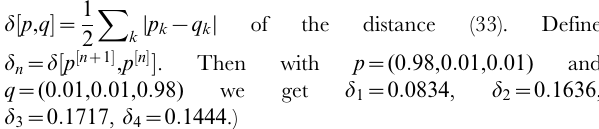
p ffiffiffiffiffiffiffiffiffiffiffiffiffiffiffiffiffiffiffiffiffiffiffiffiffiffiffiffiffiffiffiffiffi p l D E p l